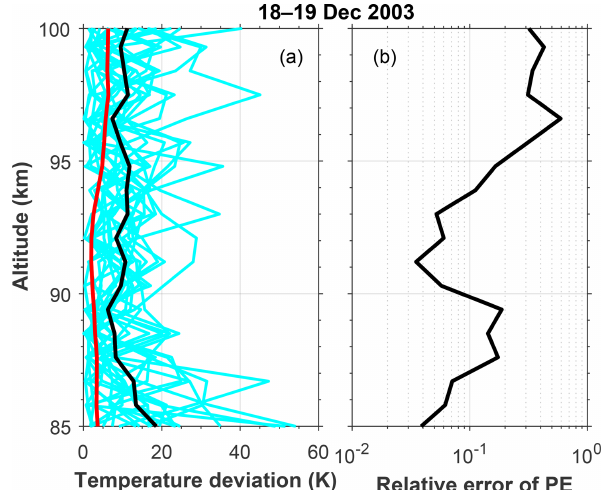
Figure 3. (a) Individual temperature deviation profiles on 18– 19 December 2003. In addition, the mean statistical uncertainties of the measurements (red solid line) and the mean fluctuations at every altitude (black solid line) are shown. (b) Relative error of po- tential energy at every altitude due to statistical uncertainty in the temperature